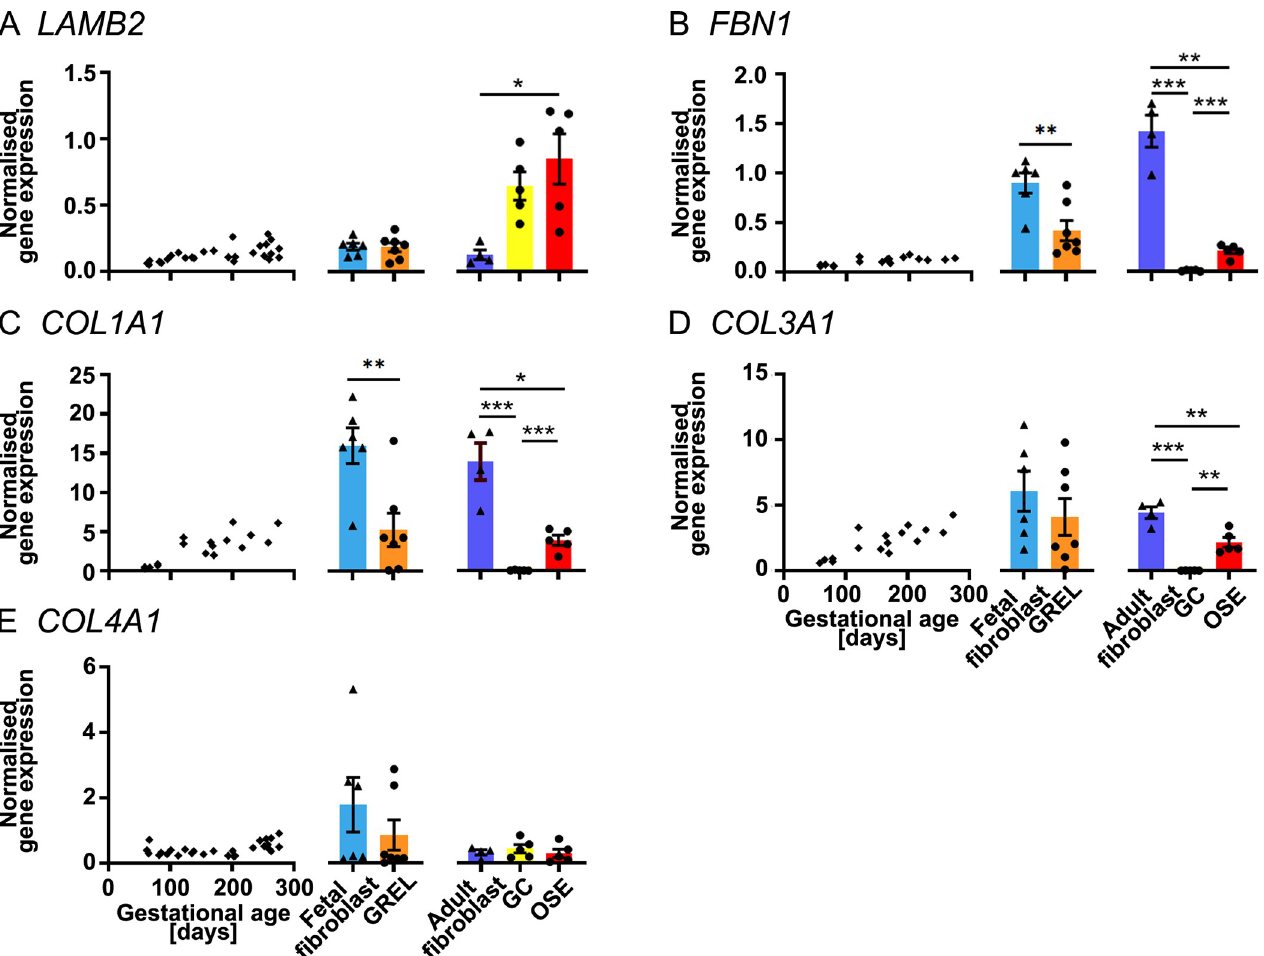
Fig 3. mRNA expression levels of extracellular matrix genes. Scatter plots in each subfigure show gene expression levels in fetal ovaries at different gestational ages (n = 27), and scatter plots for FBN1 (B), COL1A1 (C) and COL3A1 (D) are from our previous publications [30, 31]. Gene expression levels in cultured GREL cells (n = 7; gestational ages are 51, 56, 73, 110, 110, 127 and 177 days) and fetal fibroblasts (n = 6; gestational ages are 51, 73, 101, 110, 110 and 177 days) are presented as mean ± SEM (normalised to PPIA and RPL32 ) in the middle graph of each subfigure. The differences between GREL cells and fetal fibroblasts were analysed with Student’s t-tests. Data of gene expression in adult fibroblasts (n = 4), granulosa cells (GC; n = 5) and ovarian surface epithelium (OSE; n = 5) are presented as mean ± SEM (normalised to PPIA and RPL32 ) in the graph on the right side of each subfigure. Significant differences among the three adult cell types were determined by one-way ANOVA with Tukey’s post-hoc test. � P < 0.05, �� P < 0.01, ��� P <